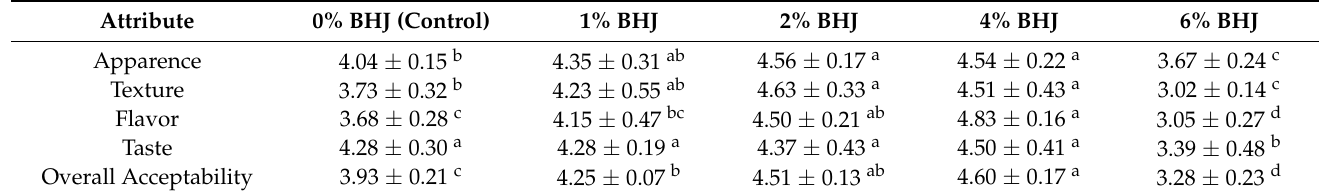
Table 2. Sensory attributes of fermented goat milk (FGM) as affected by various blue honeysuckle juice (BHJ) concentration ( v / v ) based on 5-point hedonic scale.